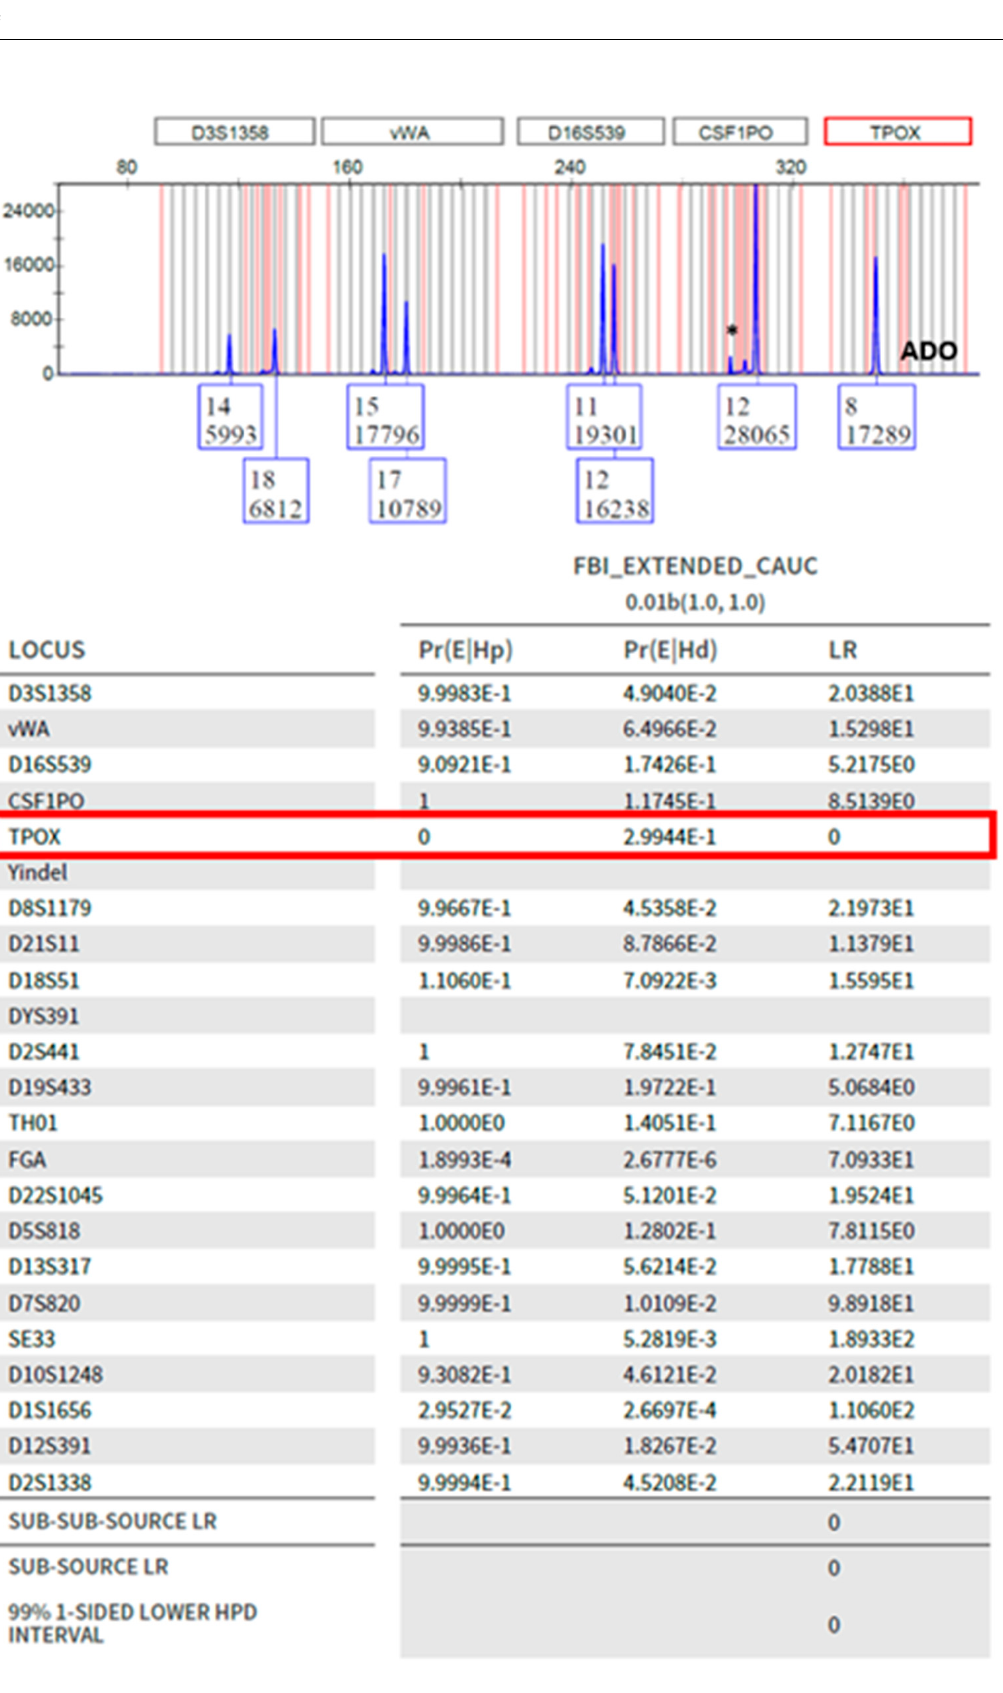
Figure 19. Drop-out from a single heterozygous TPOX allele. ADO = allele drop-out; * = pull-up. Stutter was retained for the sample when analyzed with PG.